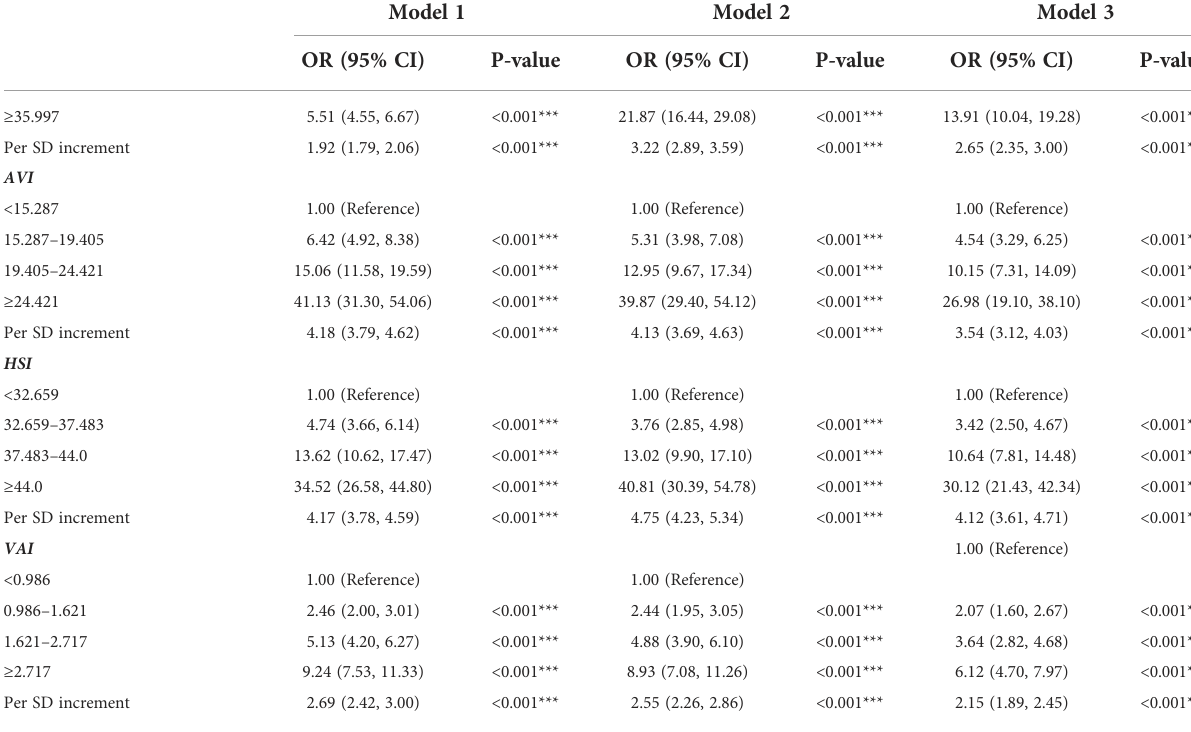
detect sex-speci fi c LAP cut-off values for diagnosing MAFLD (Table 5 and Figure 3). With the Youden method, the optimal cutoff point for diagnosing MAFLD with LAP was 47.67. At or above the 47.67 cut-off, LAP demonstrated a sensitivity of 79.2%, a speci fi city of 68.5%, a positive predictive value (PPV) of 65.2%, and a negative predictive value (NPV) of 81.5% for MAFLD. Besides, LAP values of ≥ 46.43 (AUC: 0.818) for men and ≥ 47.84 (AUC: 0.808) for women were the cut-off values best able to diagnose